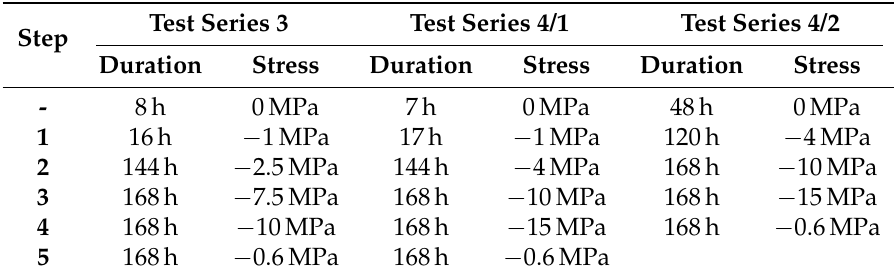
Table 3. Loading sequences for the creep test series 3, 4/1 and 4/2 [17], beginning at casting of the